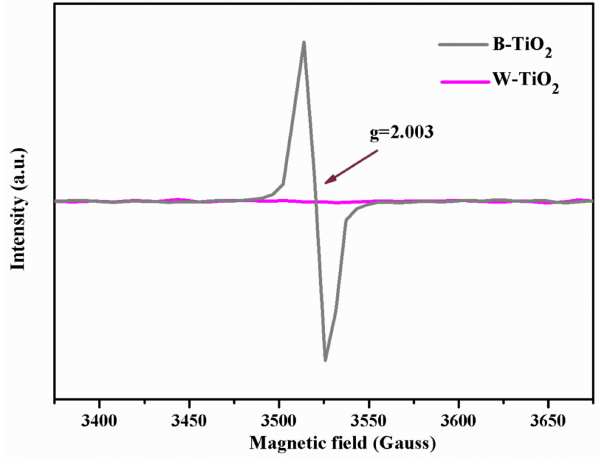
Figure 4. EPR spectra of B-TiO 2 and W-TiO 2